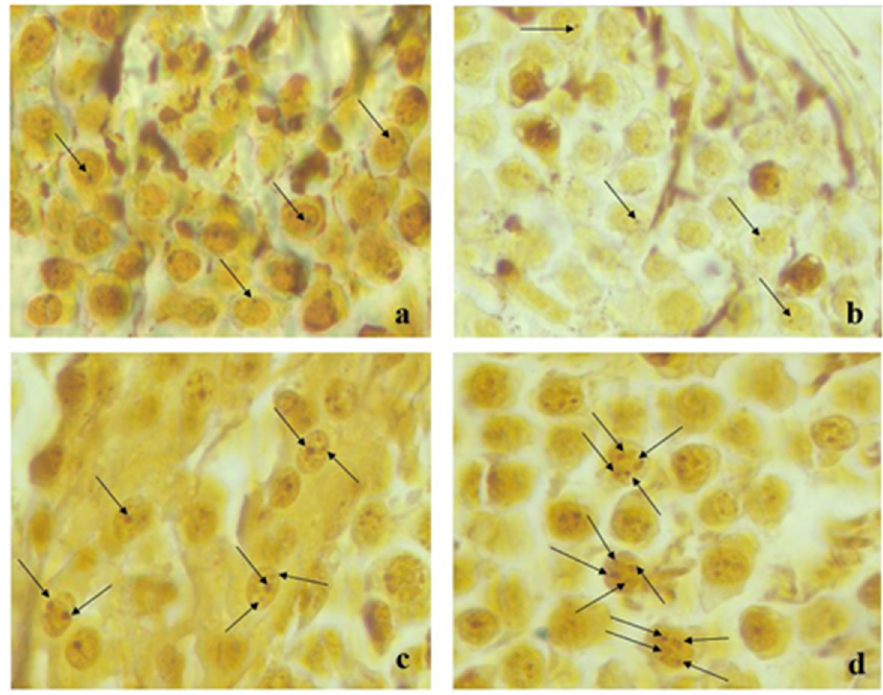
Figure 4. Representative images of silver stained NOR ( a ) Control, ( b ) Sham, ( c ) Early T/D, ( d ) Late T/D for testicular cells. The arrows showed the AgNOR proteins.